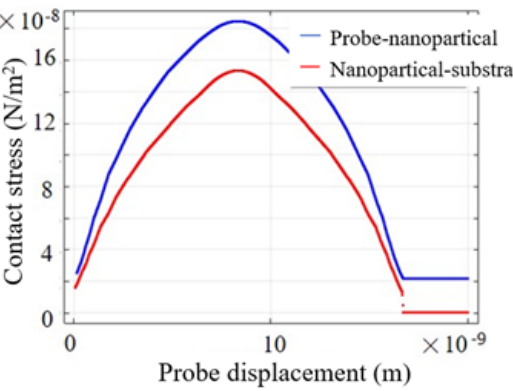
Figure 5. Contact stress curve with probe